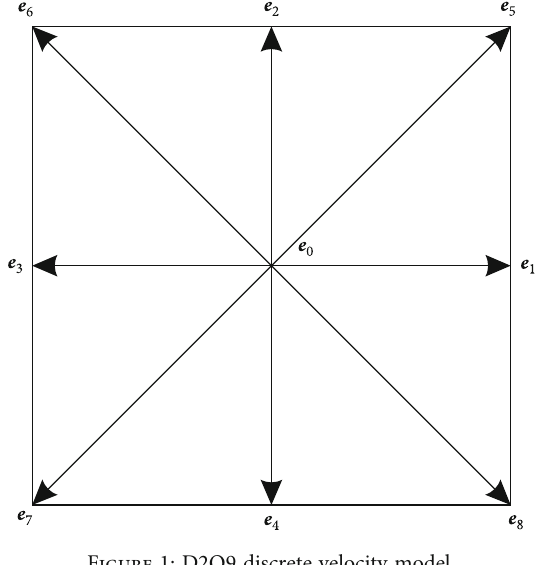
Figure 1: D2Q9 discrete velocity model. Table 1: The D2Q9 velocity set in explicit form.